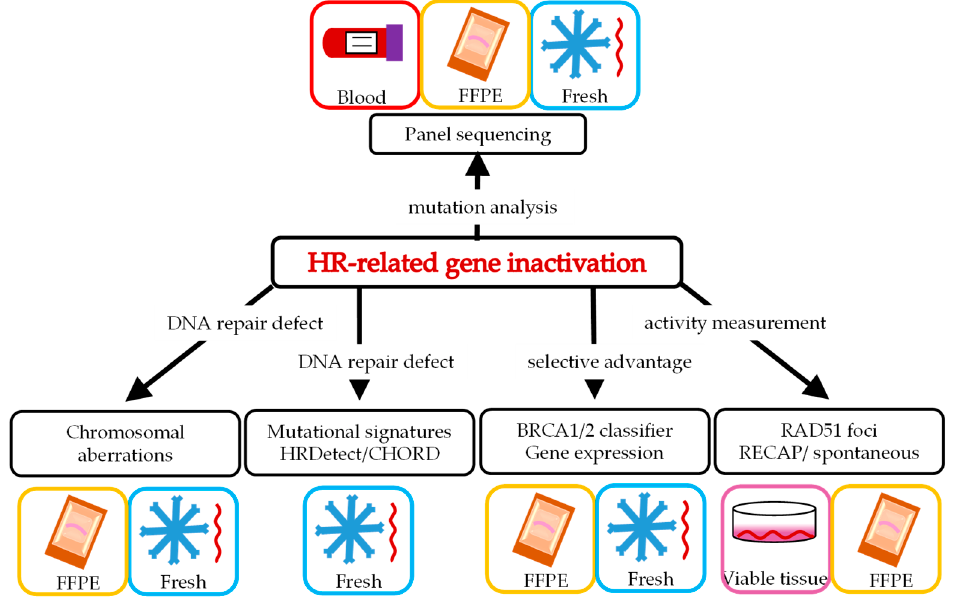
Figure 2. Homologous recombination deficiency (HRD) biomarkers and material needed to analyze the particular biomarker (see text for details). FFPE = formalin fixated paraffin embedded; Fresh = fresh frozen material; HR= homologous recombination.